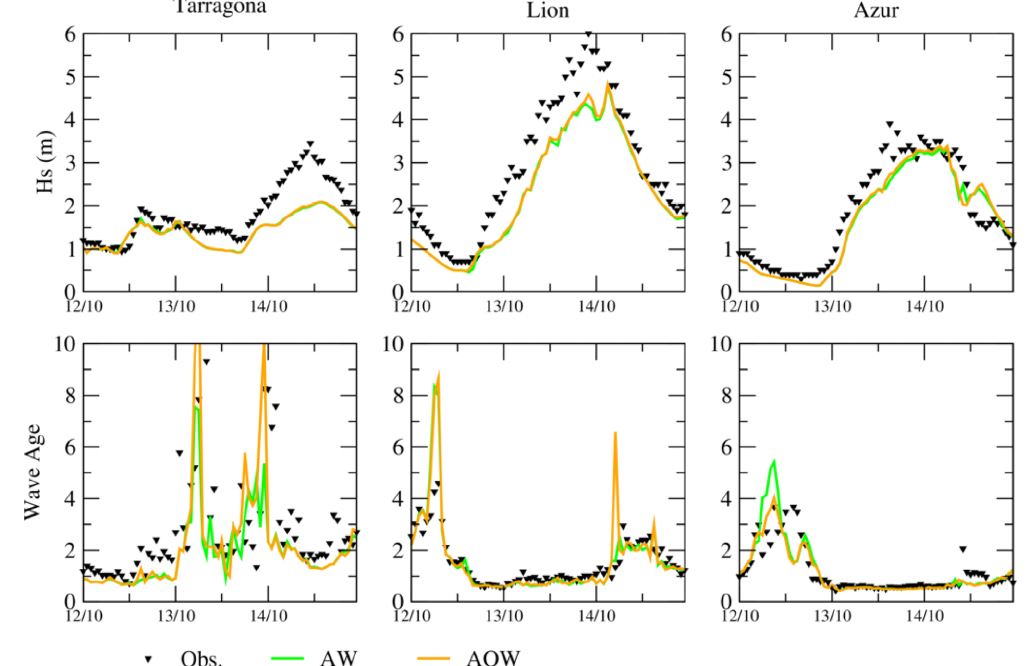
Figure 9. Time series of simulated significant wave height H s and wave age at the three moored buoys Tarragona, Lion and Azur at 00:00UTC on 12 October to 00:00UTC on 15 October, using successive forecasts of each experiment including WW3 ( + 1– + 24h forecast ranges each